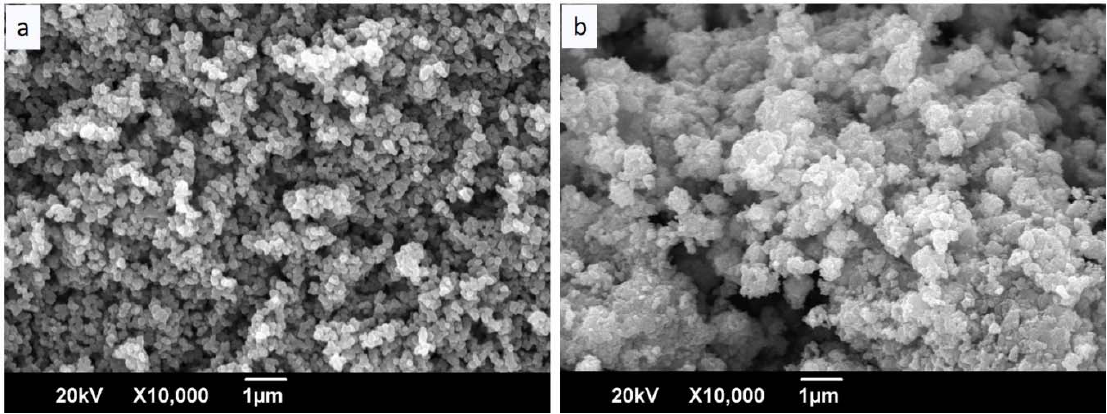
Figure 5. SEM images of the ( a ) TiO 2 and ( b ) CuO particles.